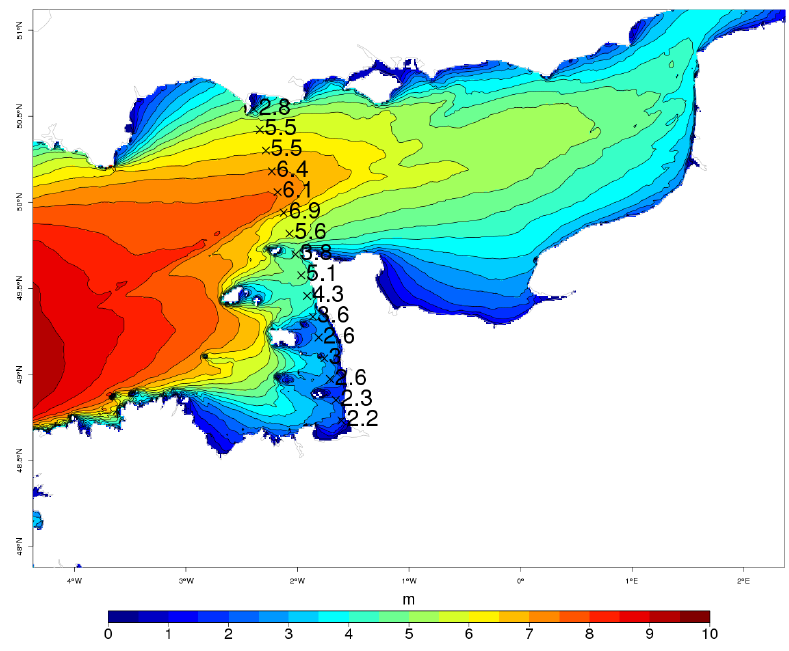
Figure 10. SWH (in m) in the English channel from the operational coastal model WaveWatch3 (WW3) with unstructured grid of a resolution of 200 m during the event of 8 February 2016 at 06:00 UTC. The model is driven by the wind forcing from the model ARPEGE. The SARAL/AltiKa track is overlaid and indicates SWH (in m) at the peak of the event near the